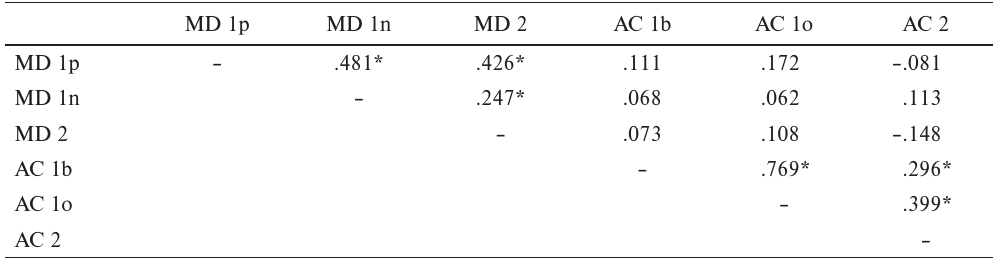
Correlation matrix of the MABC-2 test – age band